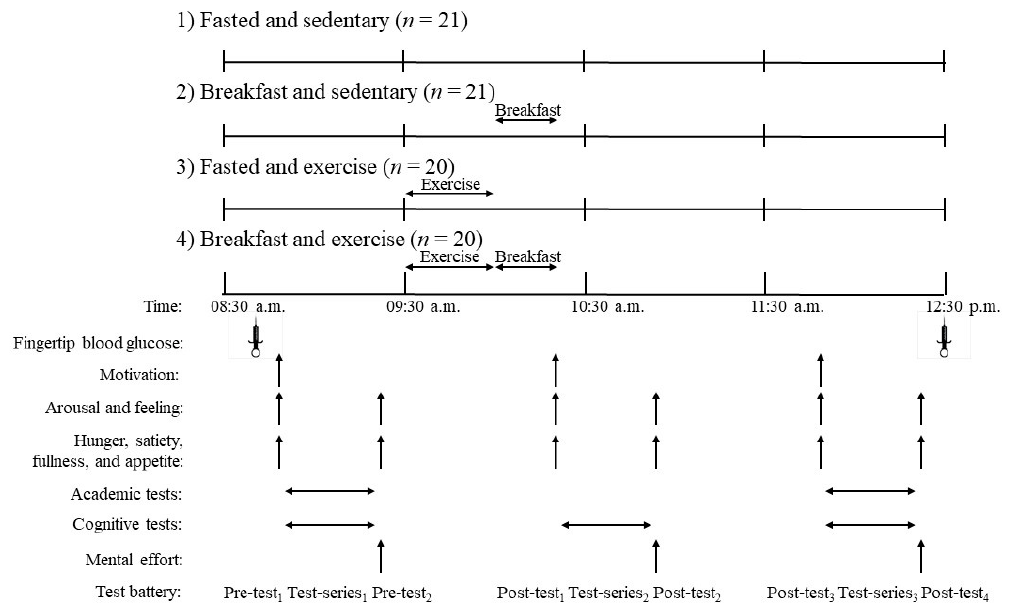
Figure 1. A schematic representation of the study protocol. Exercise involved 8 min of treadmill running at a speed equivalent to 60% of peak oxygen uptake followed by 20 min of bilateral coordinative ball exercises. Breakfast contained 382 kcal and consisted of a sandwich and a chocolate malt powder drink. Three cognitive tests (Stroop Color-Word Test, Digit-Span Test, and Go/No-Go Task) were conducted in consecutive order for each test-series. The Wechsler Individual Achievement Test (3rd Edition) was used for academic tests of mathematical and oral word fluency for test-series 1 and test-series 3.